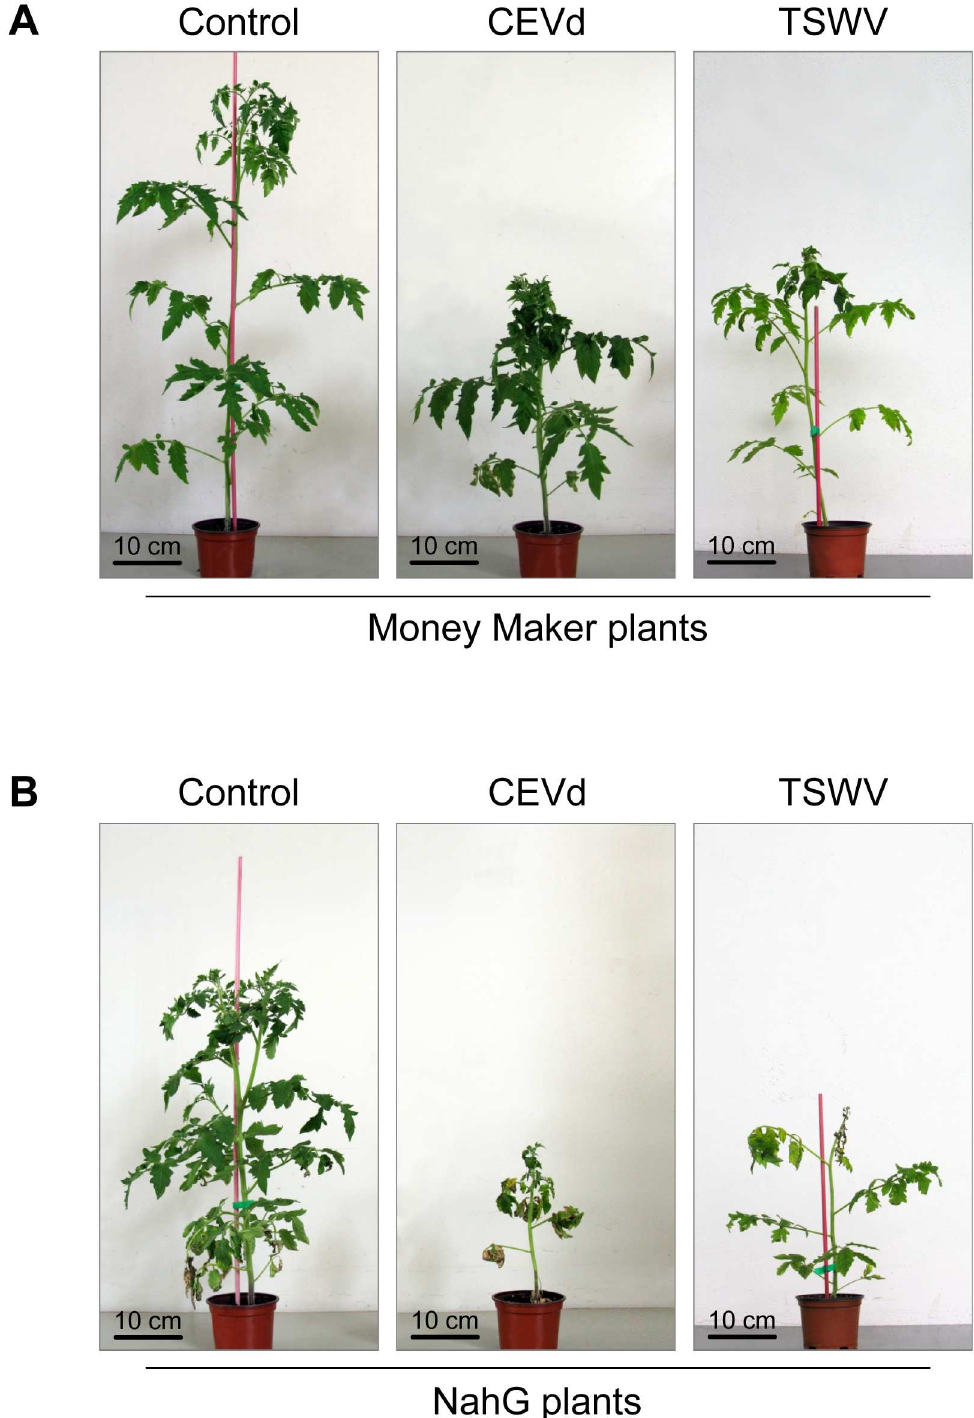
Fig 4. Growth of representative Money Makerand NahG tomato plants following inoculation with citrus exocortis viroid (CEVd) and tomato spotted wilt virus (TSWV). A) Mock-inoculated Money Maker plant (Control), Money Maker plant 4 weeks after CEVd-inoculation(CEVd), and Money Maker plant 15 days after TSWV-inoculation (TSWV). B) Mock-inoculated NahG plant (Control), NahG plant 4 weeks after CEVd- inoculation(CEVd), and NahG plant 15 day after TSWV-inoculation (TSWV).